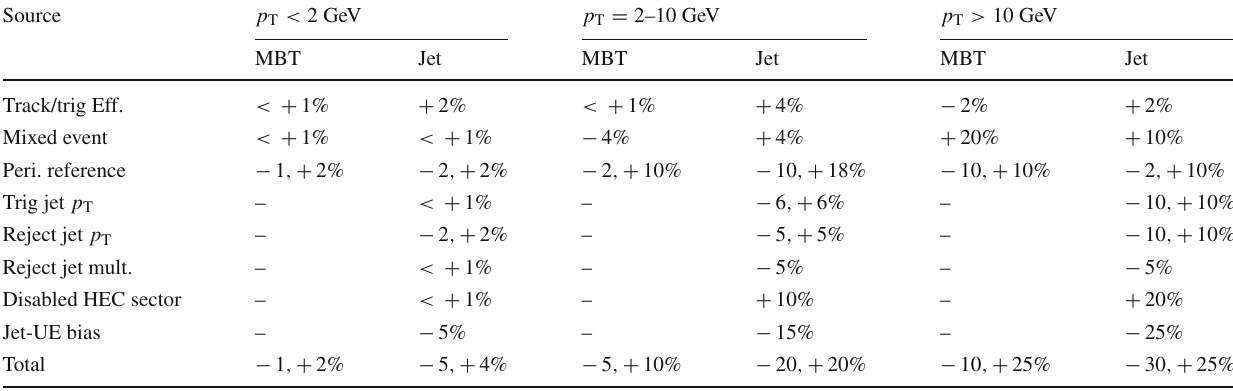
Table 1 Systematic uncertainty summary for anisotropy coefficients v 2 . The values are approximate, as they represent the average variation in each p T range, and are reported relative to v 2 . Negative and positive